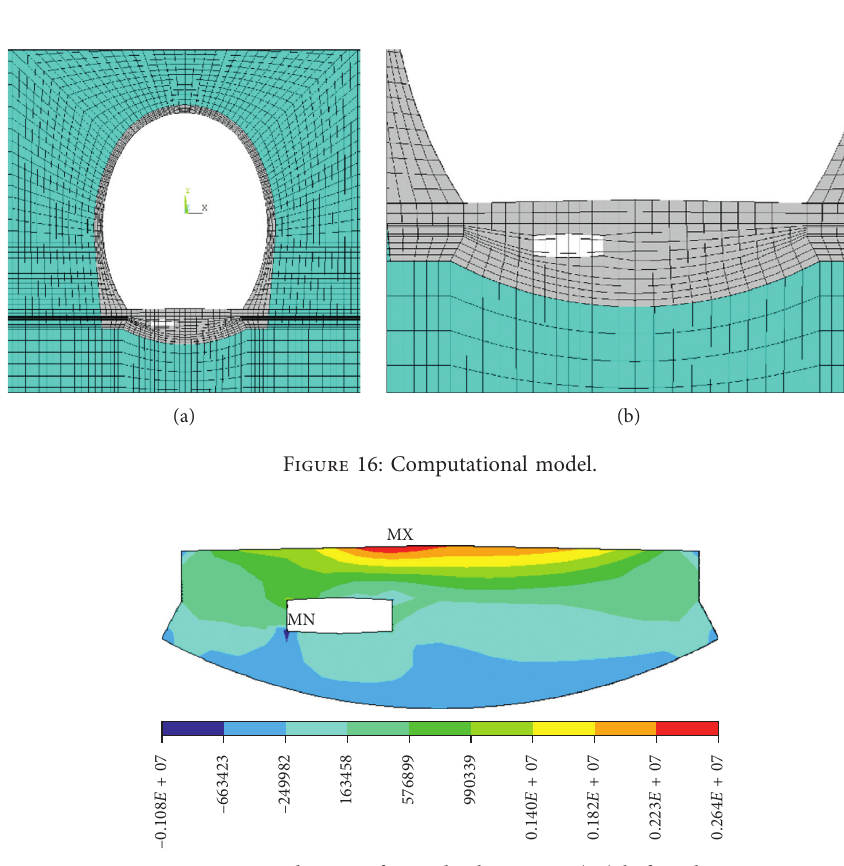
Figure 15: First principal stress of tunnel substructure (Pa) after the treatment.